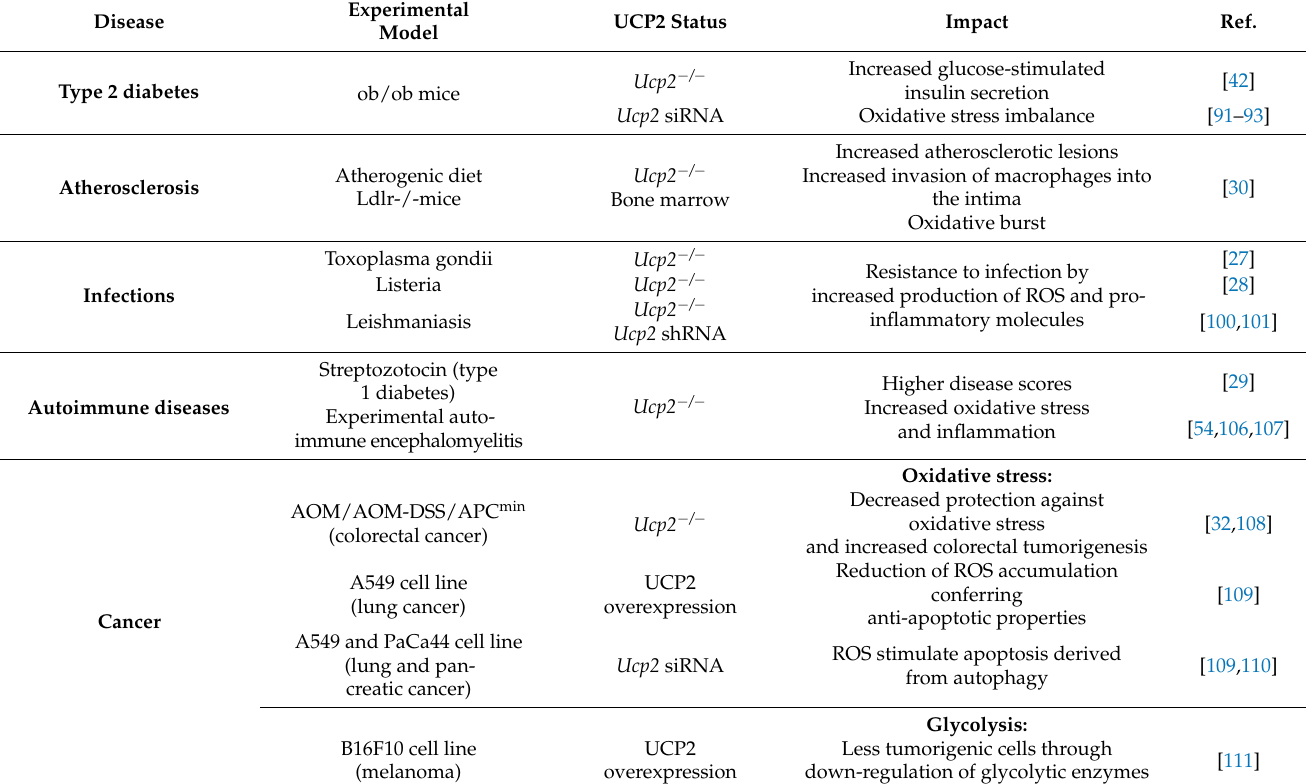
Table 1. Non exhaustive overview of pathophysiological implications of the mitochondrial protein